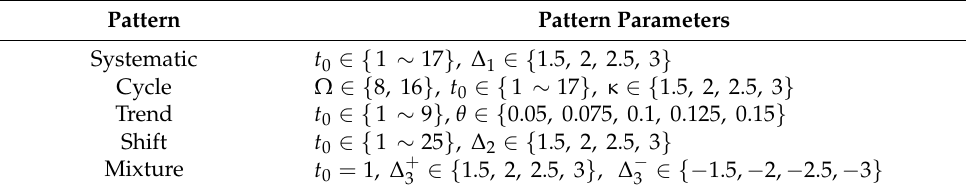
Table 7. Parameters for simulating control chart patterns.